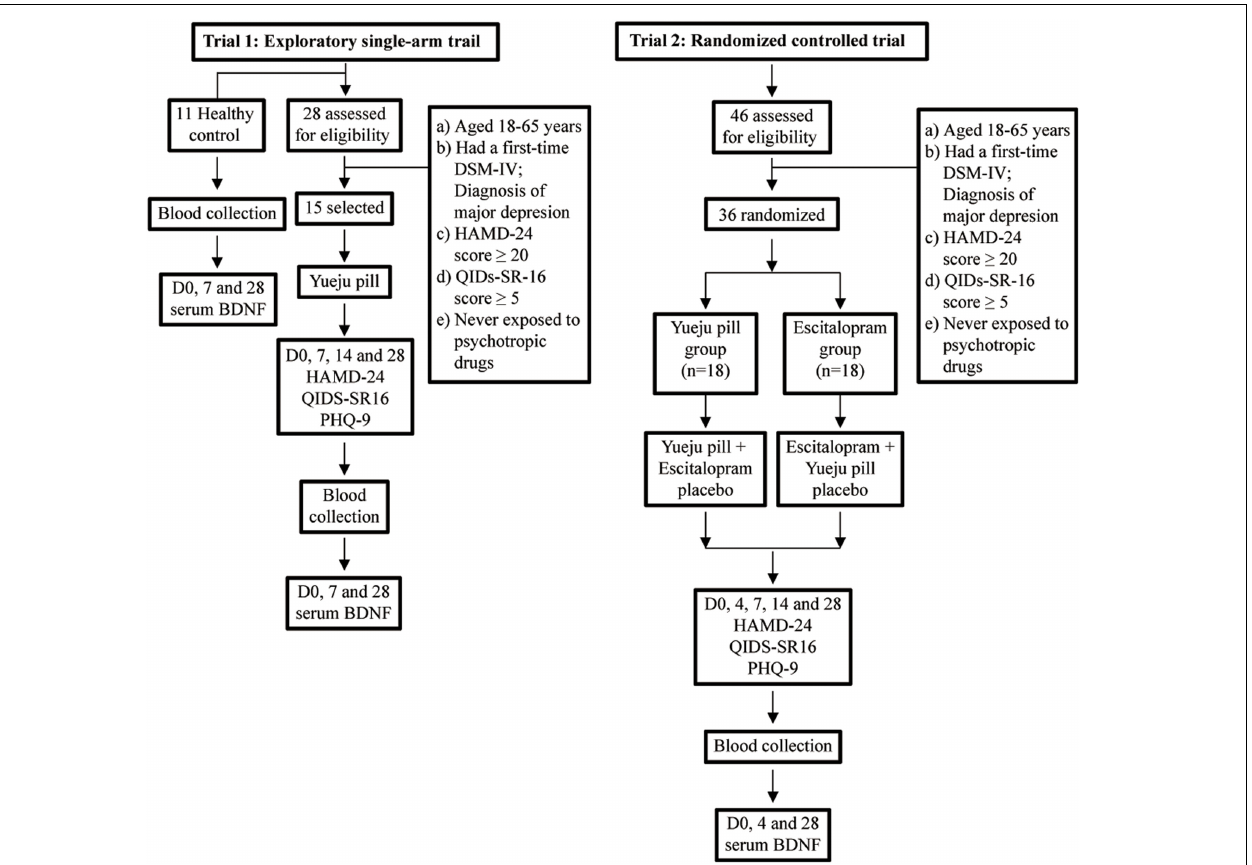
FIGURE 1 | Flowchart of enrollment, randomization, discontinuation, and completion of the treatment phases. HAMD-24, QIDS-SR16, and PHQ-9 scores and serum BDNF level were collected as indicated.